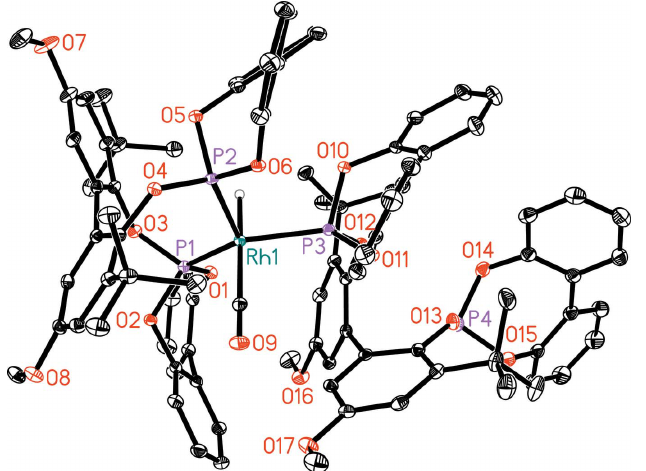
Figure 2 Molecular structure of the title compound with displacement ellipsoids drawn at 30% probability level. Deuterium and C–bound hydrogen atoms are omitted for clarity. Disordered solvent molecules are shown in only one